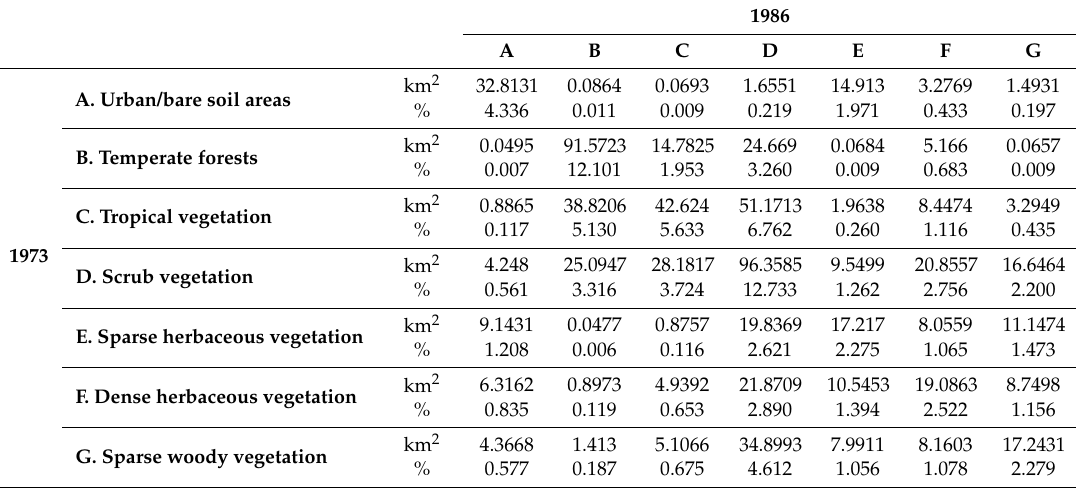
Table 10. Matrix of land use-cover changes from 1973 to 1986, in the adjacent area of Natural Protected Area Altas Cumbres (NPAAC). Victoria, Tamaulipas, Mexico.